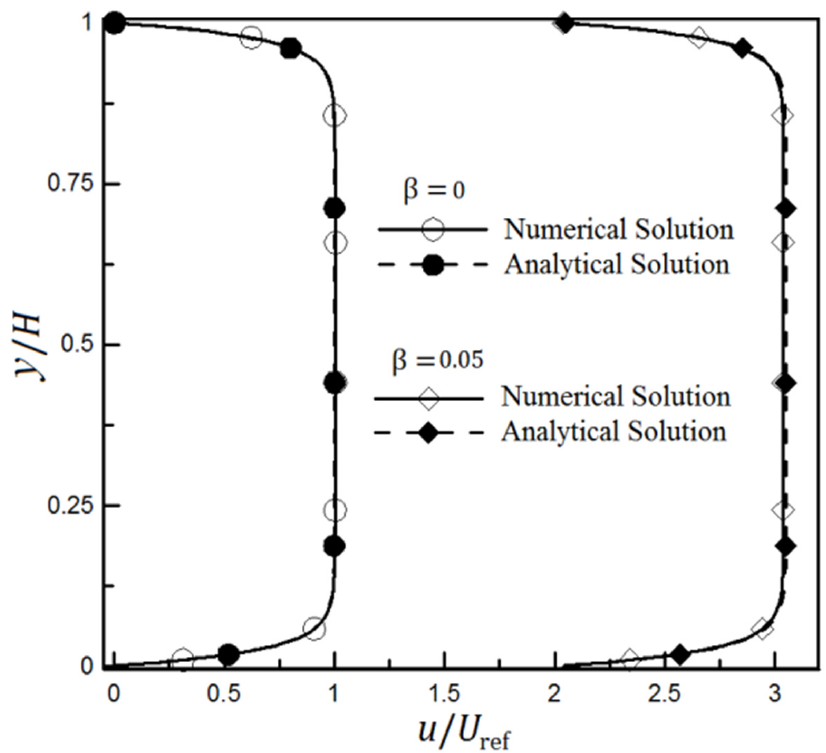
Figure 3. The velocity changes in a homogeneous microchannel through the full numerical solution model and analytical solution of electroosmotic velocity field with and without the slip boundary condition [34,62].